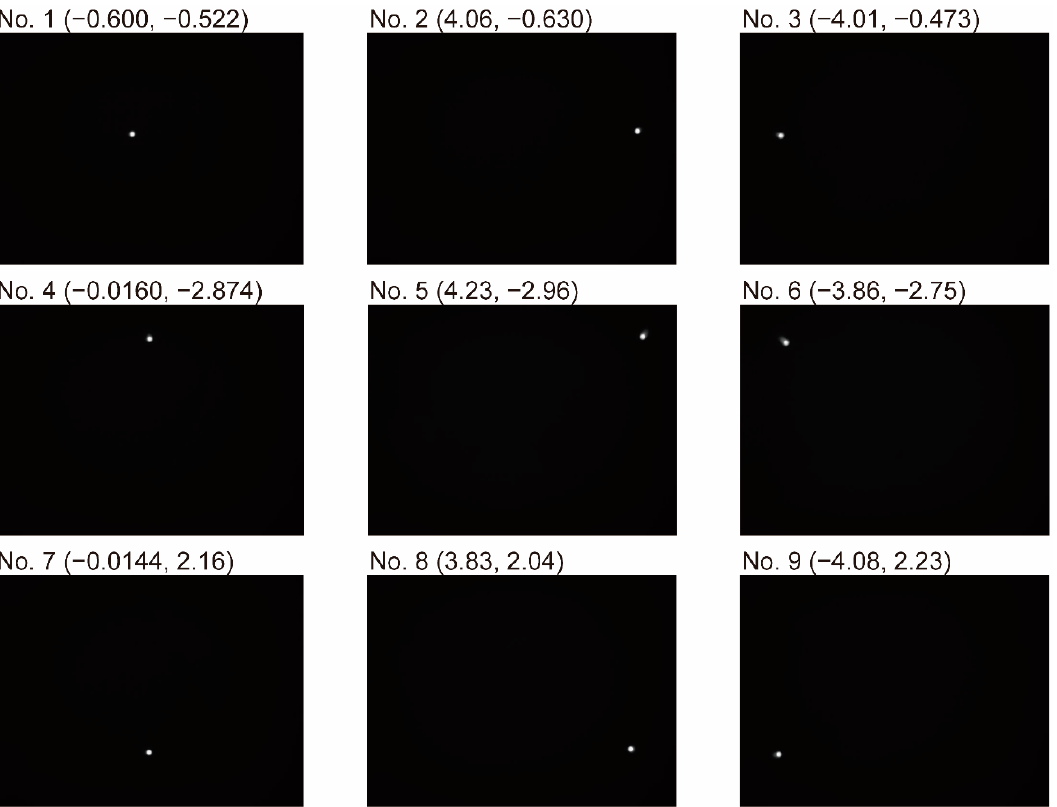
Figure A1. Captured thermal images of the light source at 0.5 m from the hybrid lens. Sensors 2020 , 20 , x FOR PEER REVIEW